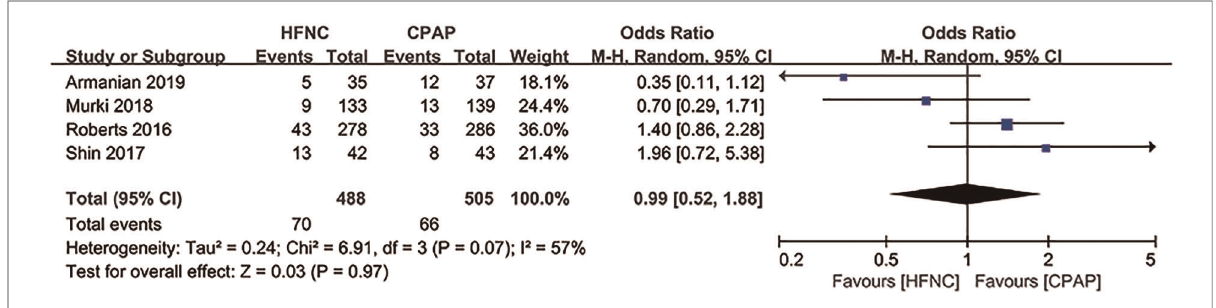
FIGURE 9 Forest plot of comparison: HFNC vs. CPAP-number-Mechanical ventilation in the studies using alternative non-invasive respiratory support as a remedy for treatment